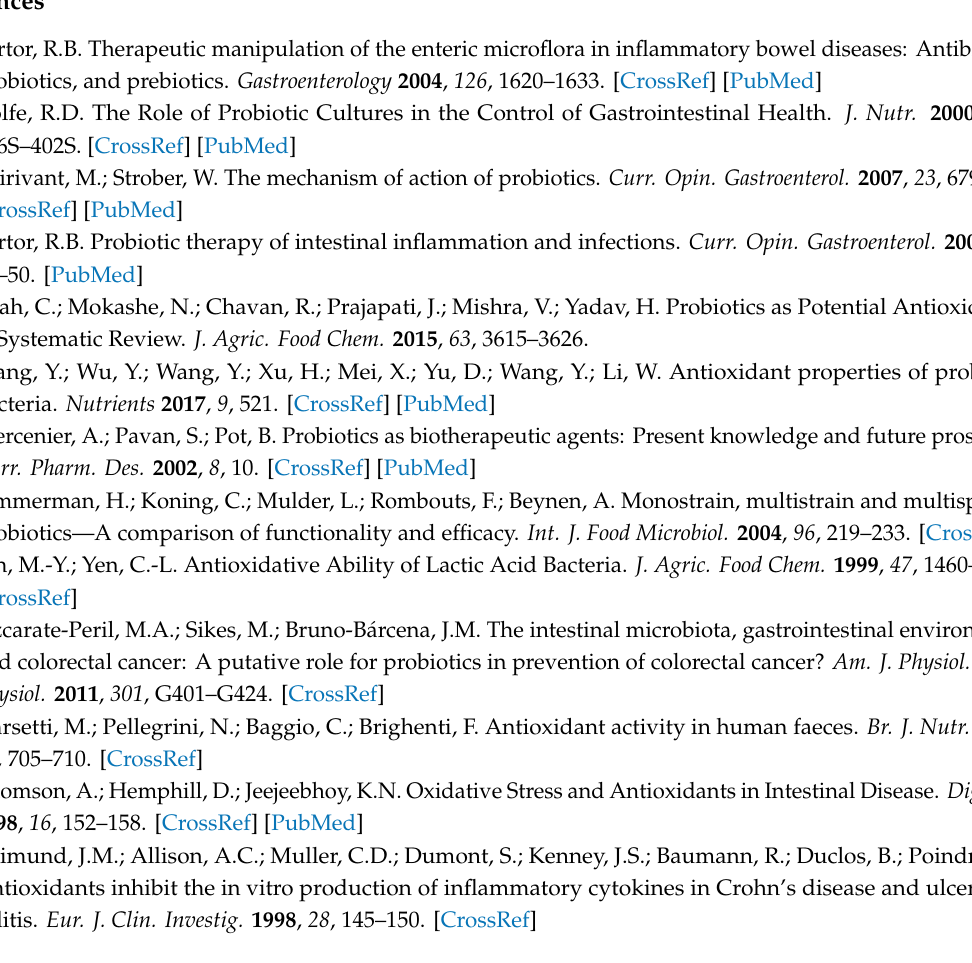
Figure S1: Nitrite determination in C. di ffi cile -infected FW, Figure S2: Nitrate determination in C. di ffi cile -infected FW, Figure S3: Protein carbonyl assessment of C. di ffi cile -infected FW, Figure S4: Spearman’s correlation analysis of i) FRAP and iron chelation, ii) DPPH and iron chelation, and, iii) DPPH and copper